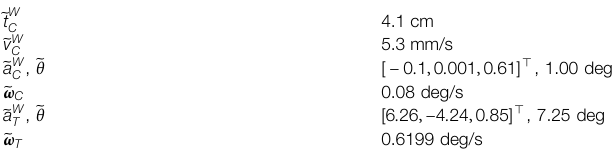
TABLE 1| Estimation errorstatistics forthenavigationalstates. All errorvaluesare the median L2 norm between the estimated and true values, except for $ a , which is computed as $ a (cid:2) Log ( R u (cid:14) R ) (cid:2) [ δ a x , δ a y , δ a z ] u and $ θ (cid:2) (cid:14) R correspond to true and estimated orientations,